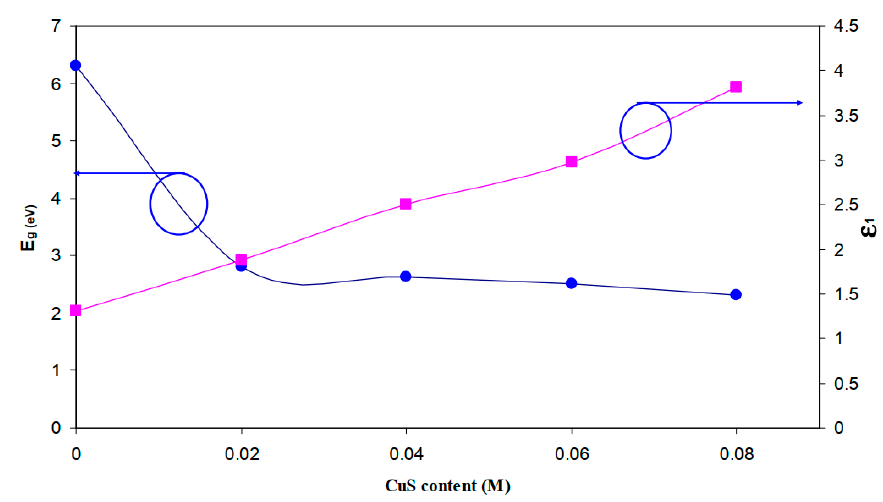
Figure 29. Energy bandgap and optical dielectric constant against amounts of CuS [281].